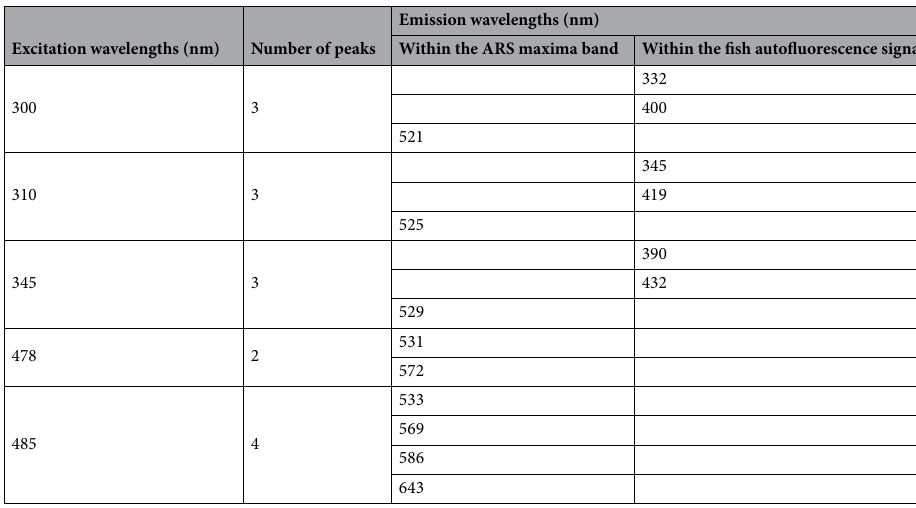
Table 2. The 15 fluorescence peaks analysed in the glass eels with their excitation and emission wavelengths.